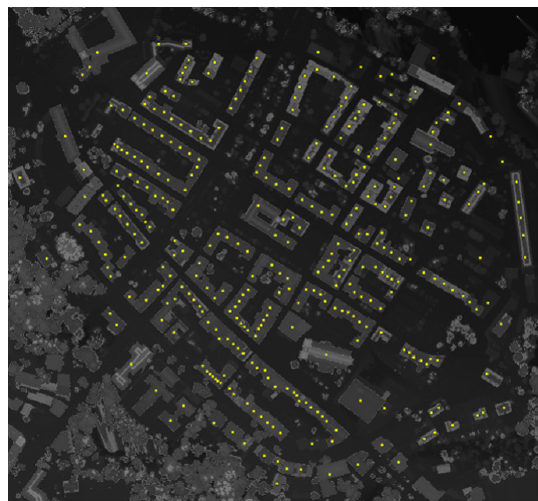
Figure 4b. Input data: LIDAR point cloud (after interpolation) and address points.